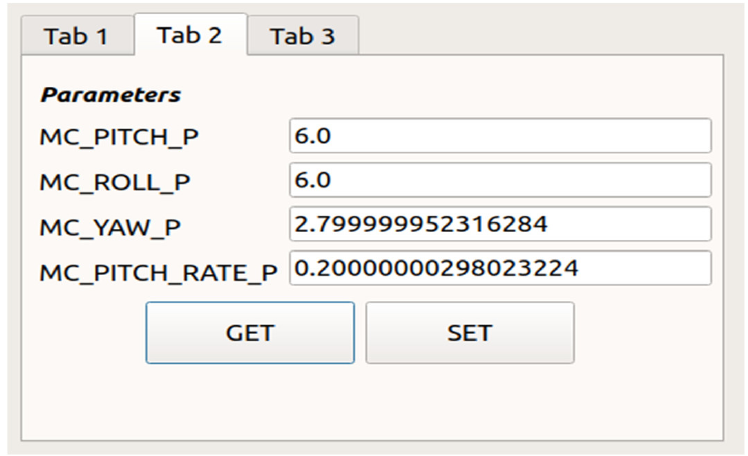
Figure 13. PX4 parameters manipulator.